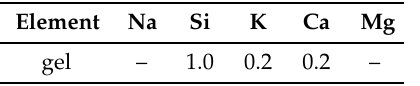
Table 6. EDX chemical analysis of gel in Figure 6 marked with *.